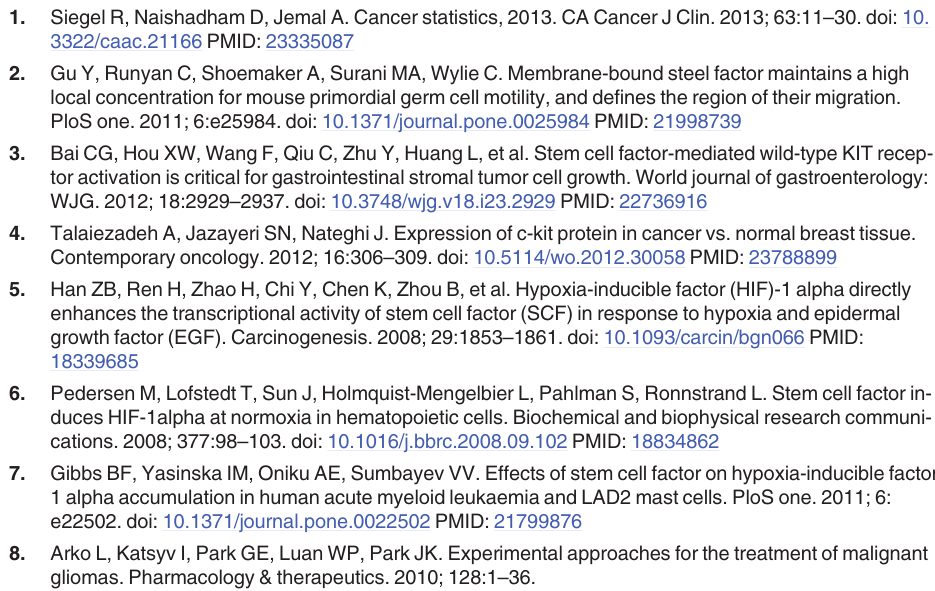
S1 Table. Correlations between HIF-1 α and SCF expression in pancreatic cancer. Statistical analysis of immunohistochemical results of HIF-1 α and SCF expression in human PDAC sur- gical samples. p values were analyzed by Spearman ’ s rank-correlation